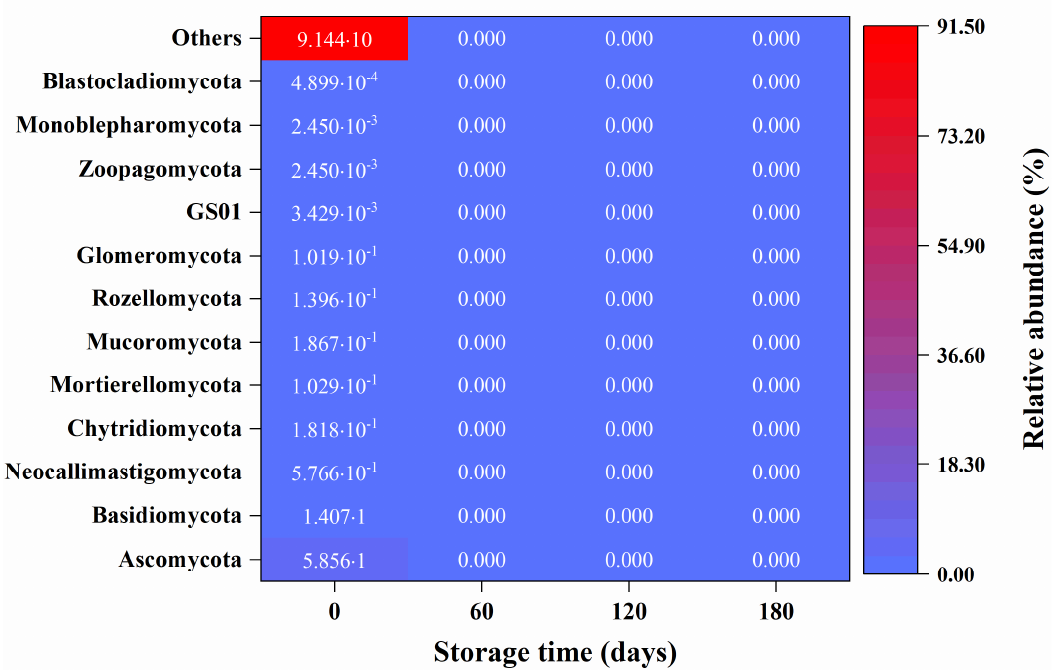
Figure 7. The relative fungal abundance at phylum level on storage days 0, 60, 120, and 180 in swine wastewater. Data are the means of three replications.